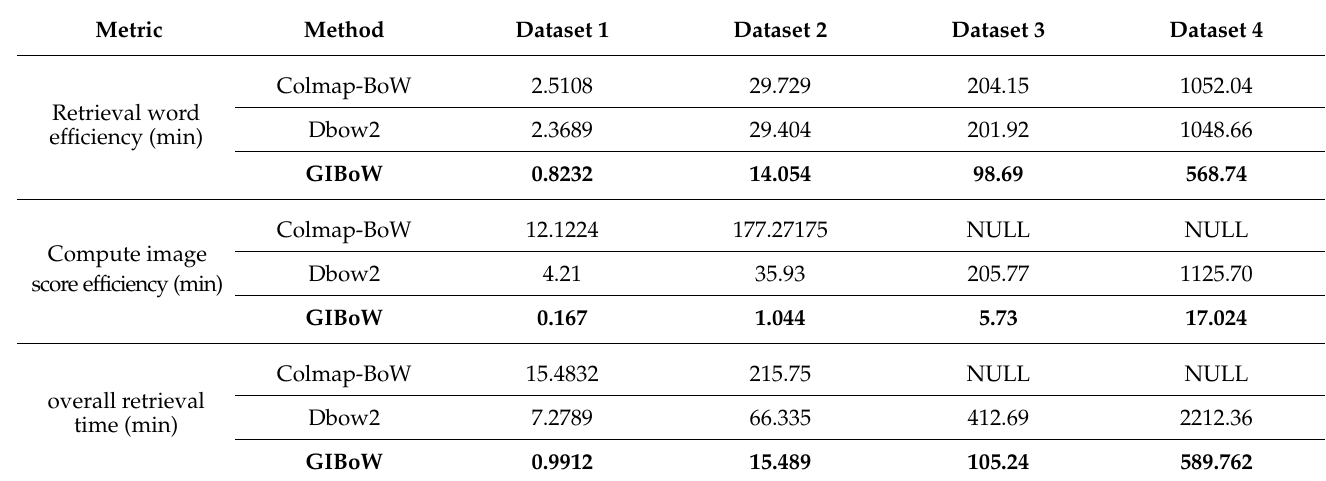
Table 2. Match pair retrieval specific time